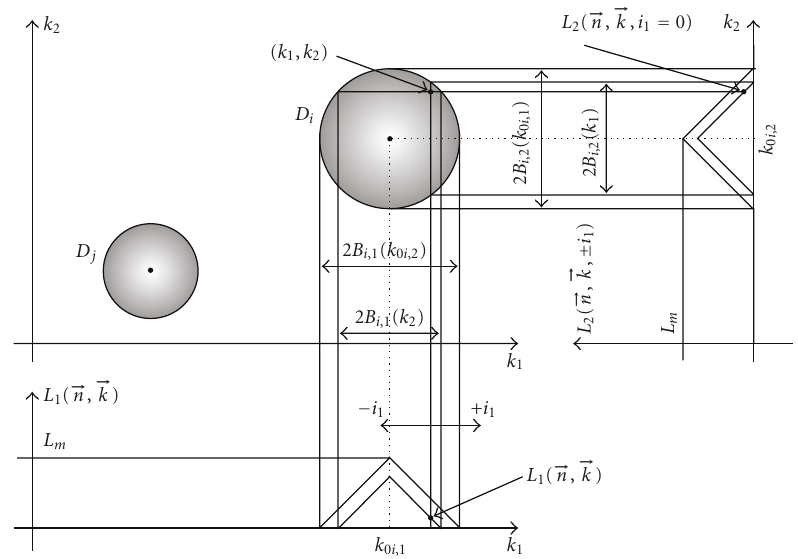
Figure 1: Illustration of the proposed 2D method